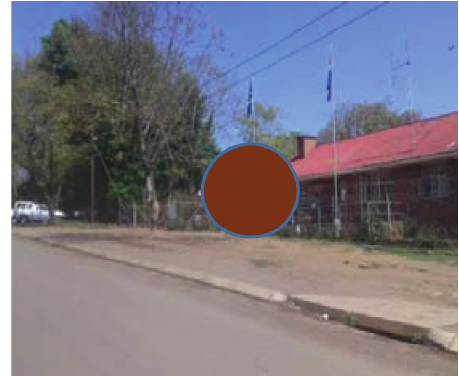
Figure 4: SAPS: site one.